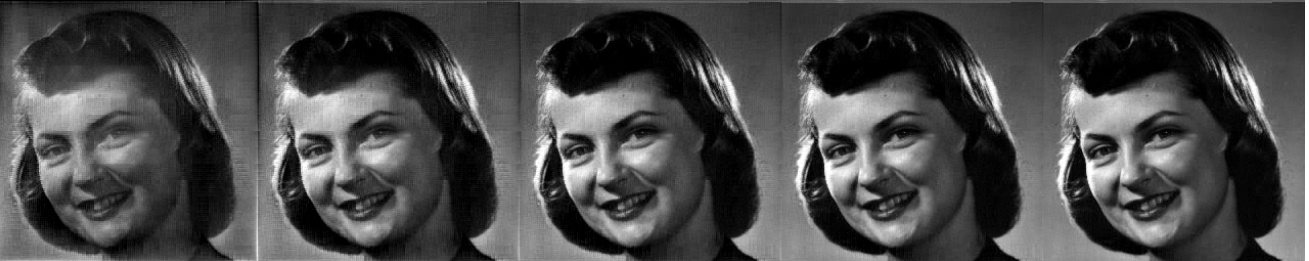
Figure 8. The first 5 iterations of recursive multi-grid inverse Radon transform of a